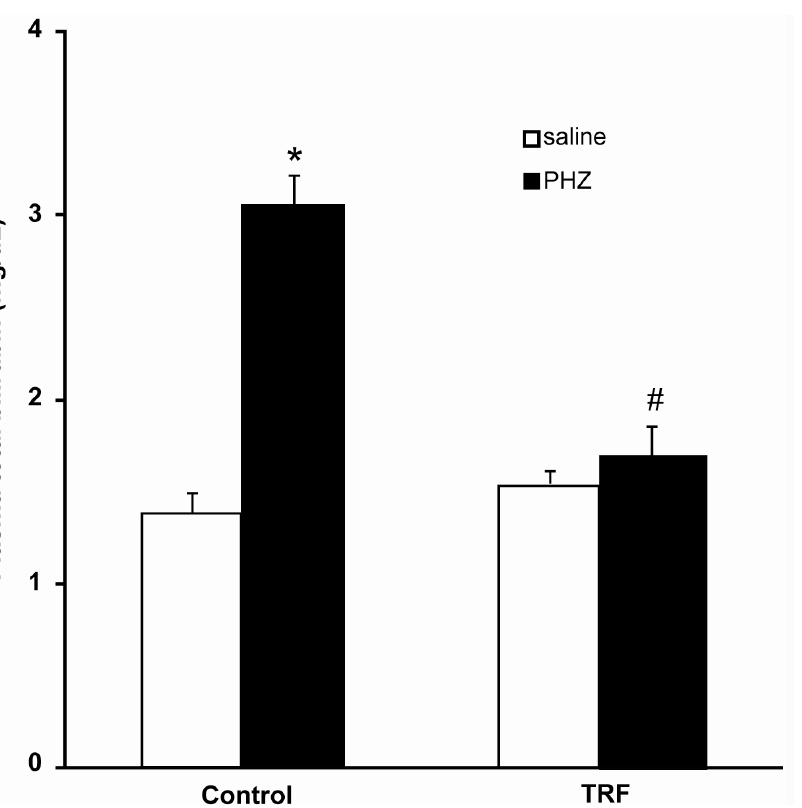
Figure 1. Plasma total bilirubin. Bars represent mean 6 standard error (n=6). *Different from the saline-treated group (P , 0.005), # different from the control + PHZ (p , 0.01). [TRF: tocotrienol-rich fraction; PHZ: phenylhydrazine].